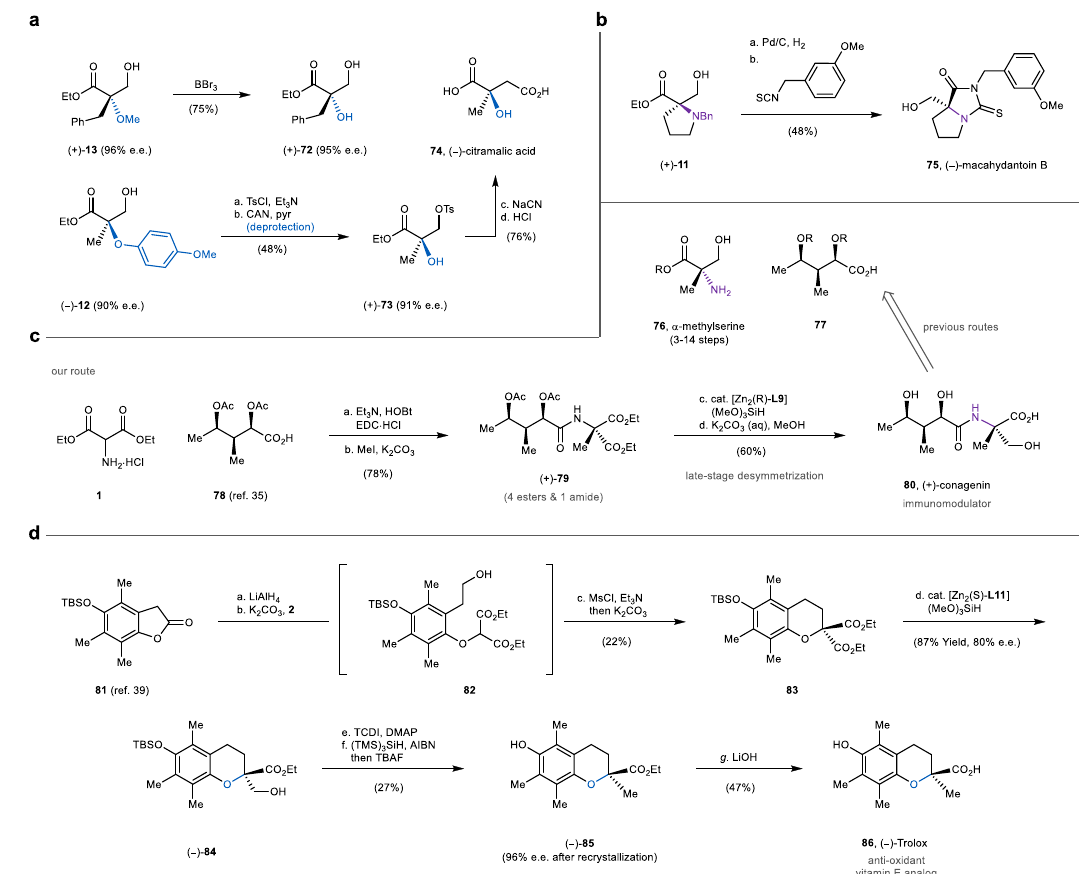
′ -ethylcarbodiimide. d SynthesisofchiralTroloxviathedesymmetrizationofcyclic malonic ester. TBS tert -butyldimethylsilyl, Ms methanesulfonyl, TCDI thiocarbo- nyldiimidazole, DMAP 4-dimethylaminopyridine, AIBN azobisisobutyronitrile, TBAF tetra- n -butylammonium fl uoride.